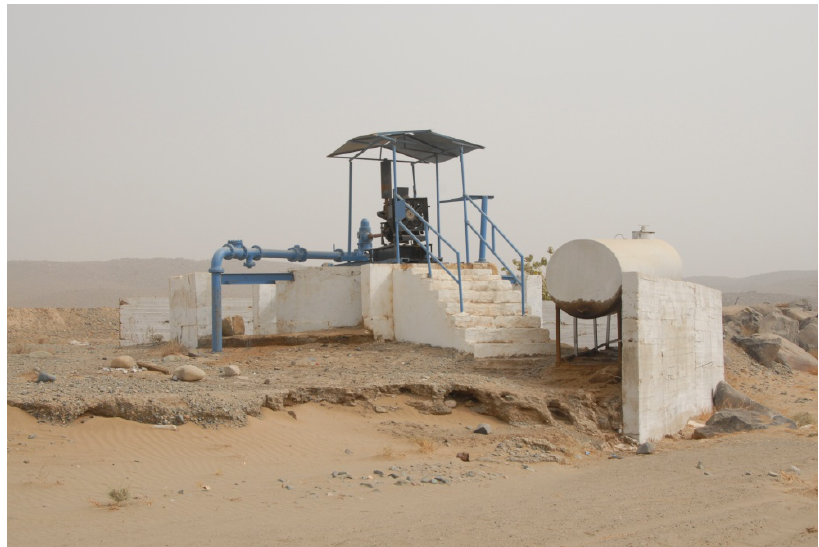
Figure 3. Abandoned municipal well that served a village water treatment